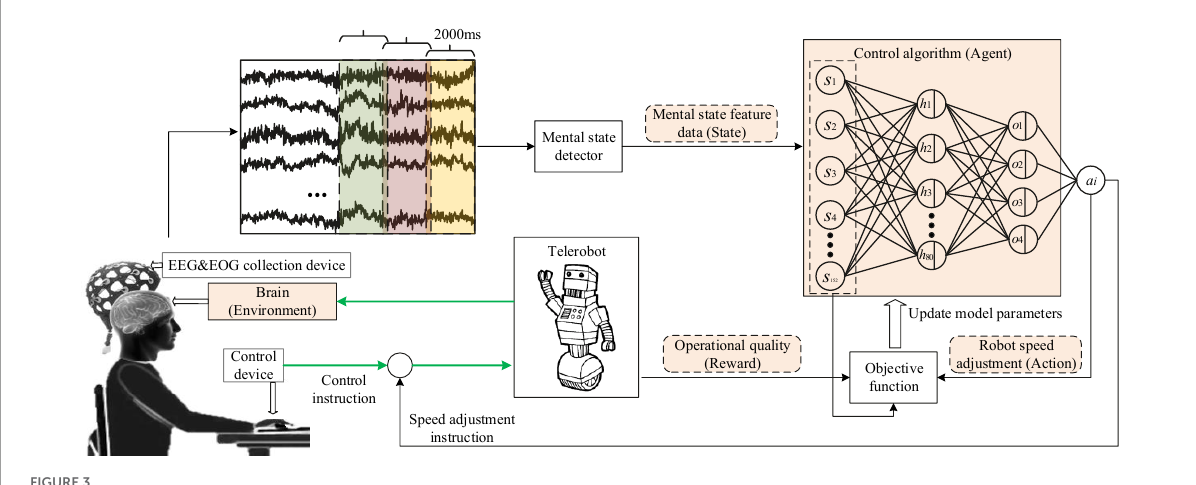
FIGURE3 The figure shows the update process of the PSA